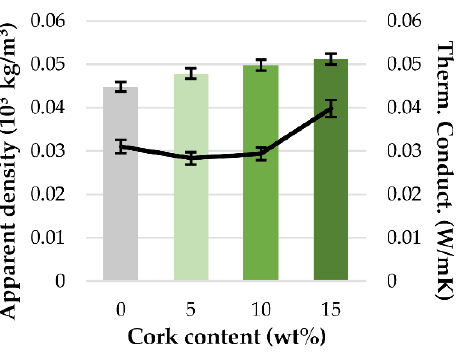
Figure 10. Correlation between apparent density (bar chart) and thermal conductivity (black line) of polyurethanes containing increasing cork content. The error bars stand for standard deviation error.